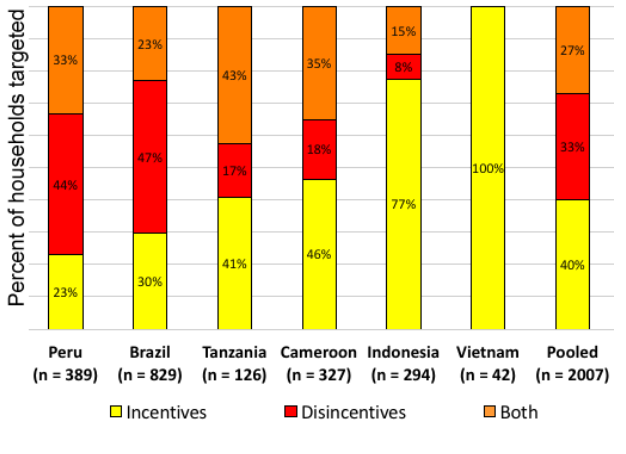
Fig. 2 . Percent of targeted households in phase 2 that received incentives, disincentives, or